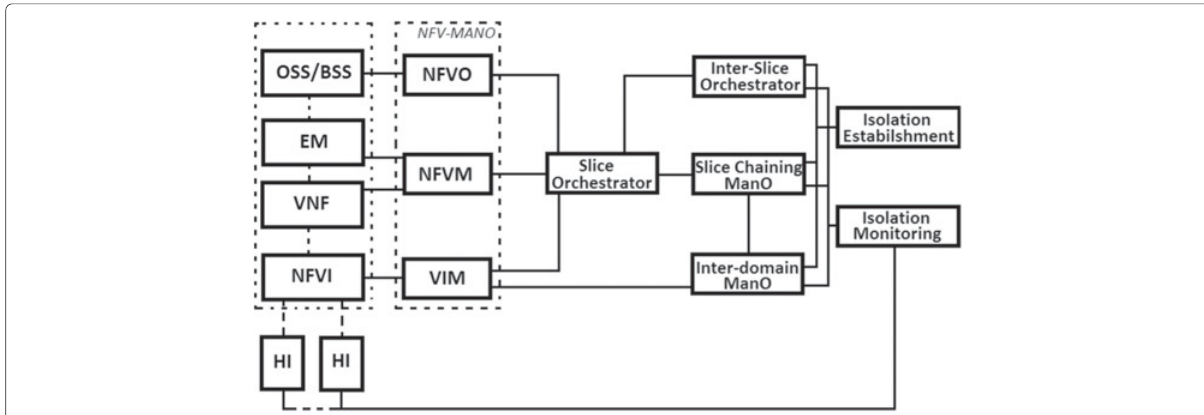
Fig. 9 The extended NFV-MANO architectural framework for isolated sliced environment (OSS/BSS - Operations Support System/Business Support System; EM - Element Manager; VNF - Virtual Network Function; NFVI - Network Functions Virtualization Infrastructure; HI - Hardware Infrastructure; NFVO - Network Functions Virtualization (NFV) Orchestrator; NFVM - NFV Manager, VIM Virtual Infrastructure